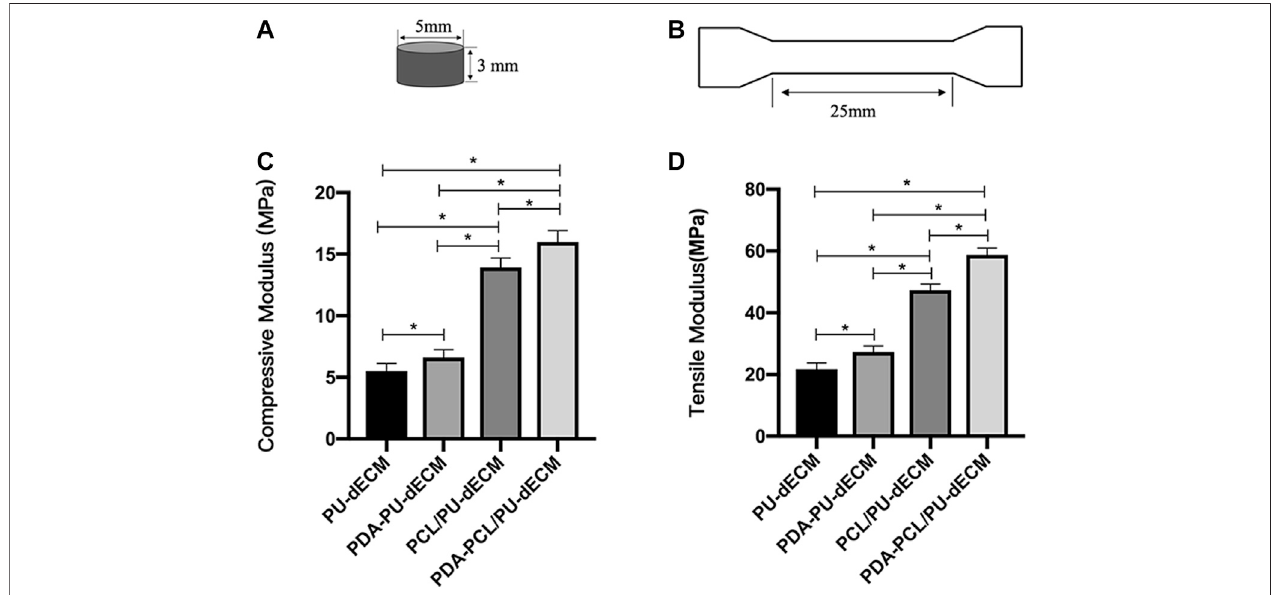
FIGURE3 | Compressive and tensile modulus ofthe scaffolds. (A) Graphical representation ofthe compressive test specimen. (B) Graphical representation of the tensile test specimen. (C) Compressive modulus of the scaffolds. (D) Tensile modulus of the scaffolds. (* Comparison between groups, n (cid:2) 5, * p < 0.05).